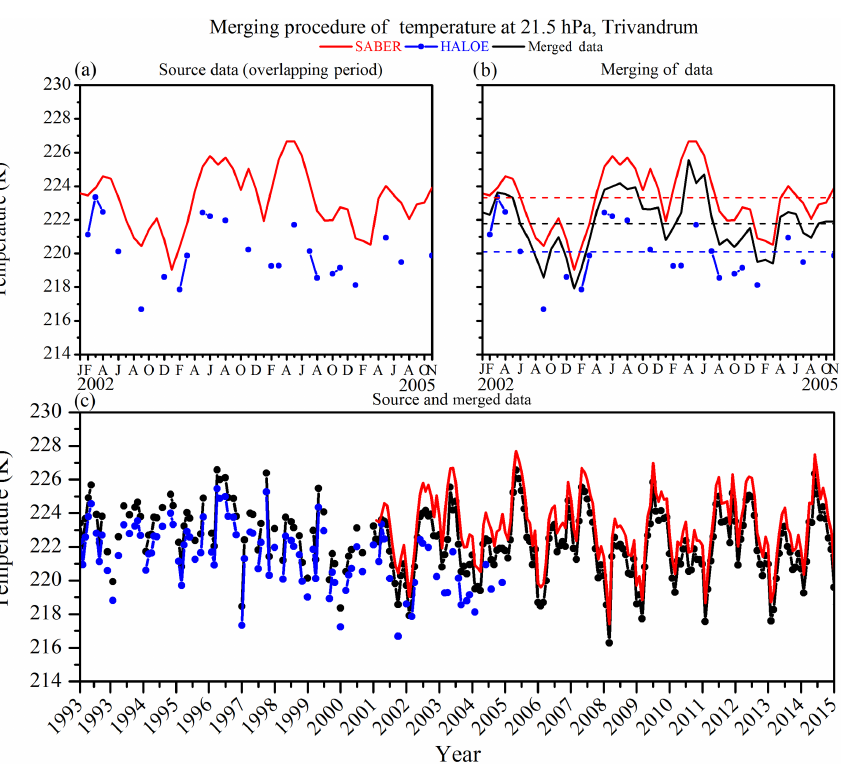
Figure 2. Merging procedure illustrated for temperature at 21.5hPa over Trivandrum. (a) Monthly mean source data during overlapping period (January 2002–November 2005) for HALOE and SABER at 21.5hPa over Trivandrum. (b) The merged product (black) resulting from the adjustment of source data to the mean reference indicated by black dashed line (mean of co-located HALOE and SABER data) along with source data. Blue and red dashed lines show the mean of HALOE and SABER during the overlapping period. (c) Final merged temperature by applying additive offset value to the source data during